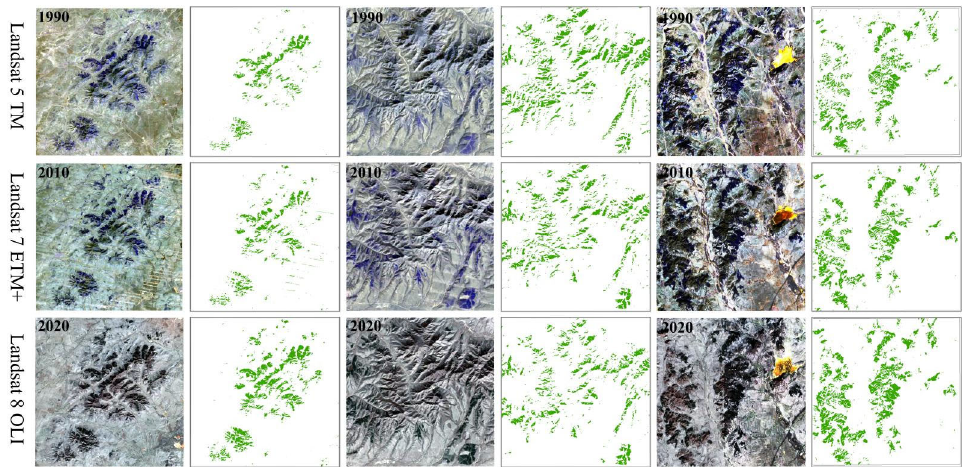
Figure 14. Extraction results of the coniferous forests on remote sensing images from different years and sensors using U 2 ‐ Net trained by Landsat ‐ 8 OLI data in the year 2020.